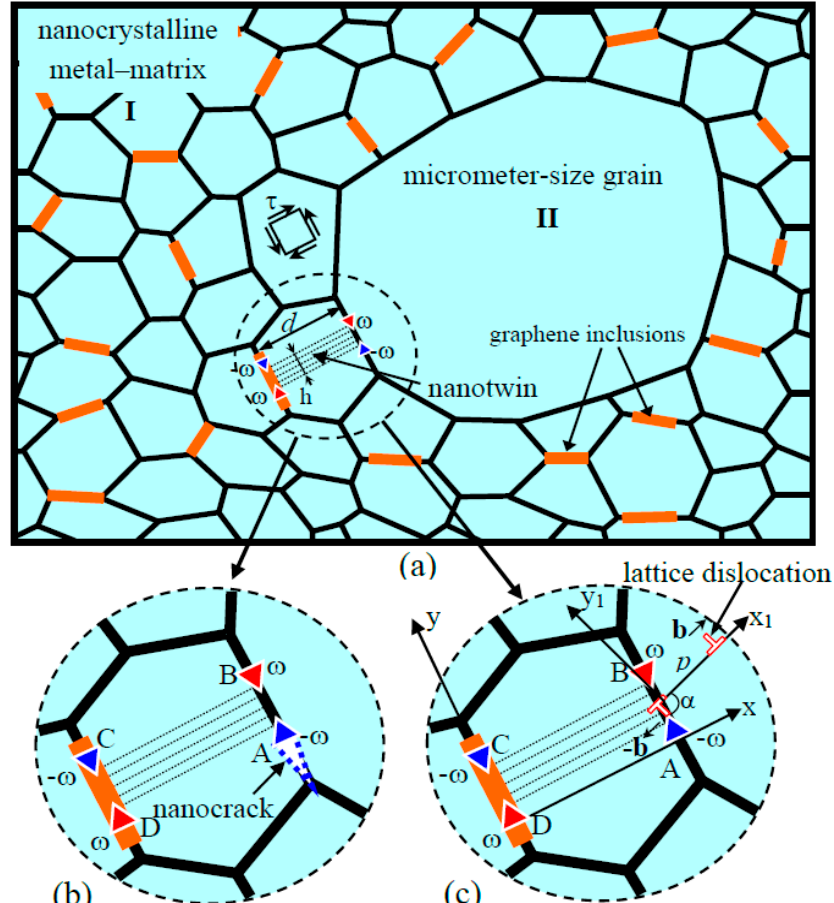
Figure 1. Model of crossover from deformation twinning to lattice dislocation slip in bimodal metal–graphene nanocomposite. ( a ) The initial structure with nanotwin, which is modeled by the disclination quadrupole ABCD. ( b ) Formation of nanocrack in the stress filed of the disclination dipole AB. ( c ) Emission of lattice dislocation from the disclinated grain boundary AB fragment.